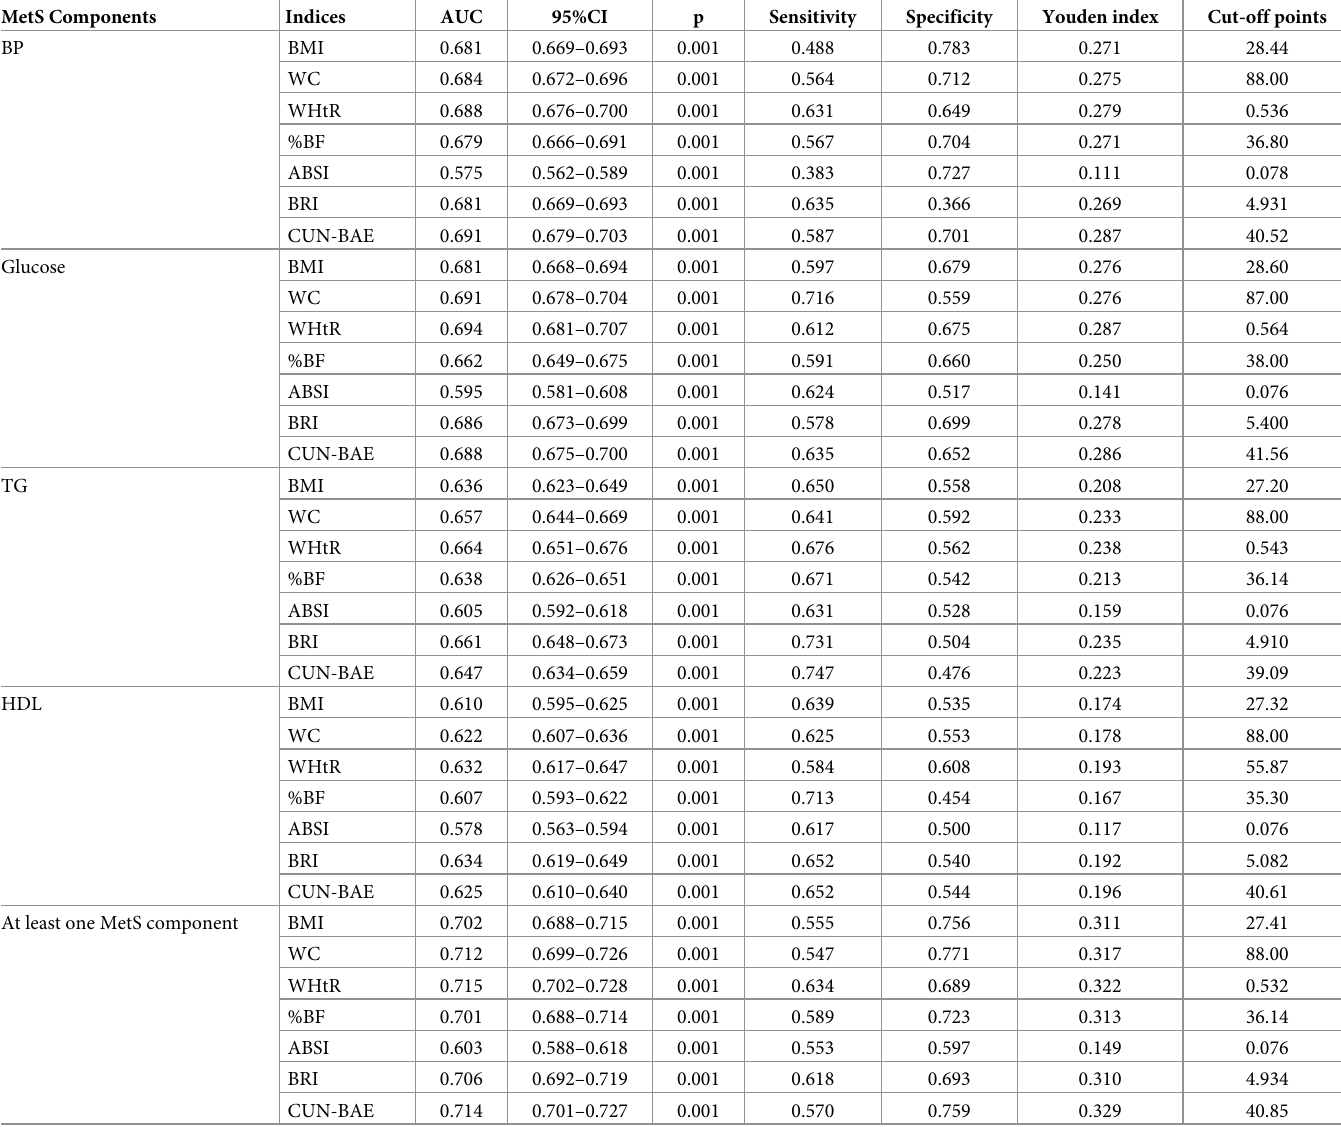
Table 4. Areas under the curve (AUCs) and cut-off points for anthropometric indices for the prediction of MetS components in women. MetS Components